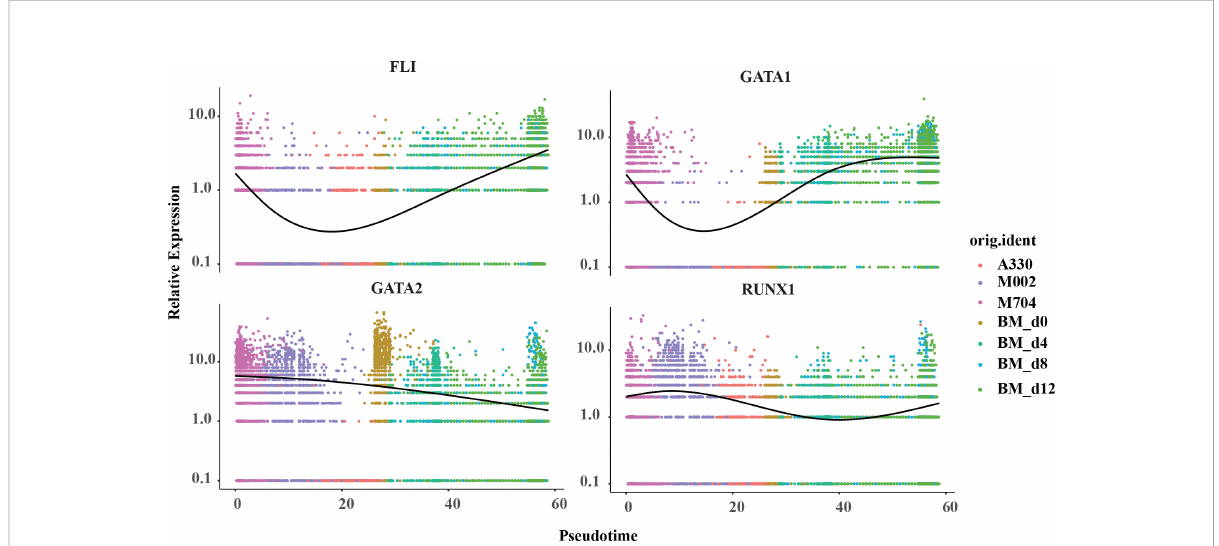
FIGURE 6 The pseudotime curve of the crucial signature genes in megakaryopoiesis. The pseudotime curve shows the transformation of marker genes FLI1, GATA1, GATA2, and RUNX1 in the combination of tumors in AMKL and normal MKs in